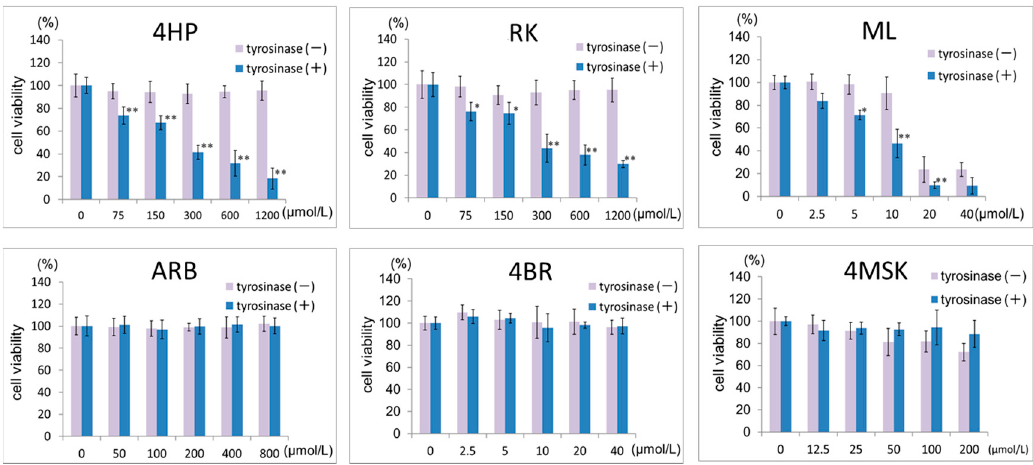
Figure 2. Effects of 4HP, RK, ML, ARB, 4BR, and 4MSK in the presence of tyrosinase on viable cell numbers (3 h after addition). Viable cell numbers are shown, with the control set as 100%. Results are presented as the mean ± S.D. of three experiments. * p < 0.05, tyrosinase ( − ) vs. tyrosinase (+) at the same concentration; ** p < 0.01, tyrosinase ( − ) vs. tyrosinase (+) at the same concentration. 4HP, rhododendrol; RK, raspberry ketone; ML, magnolignan; ARB, arbutin; 4BR, 4-n-butylresorcinol;